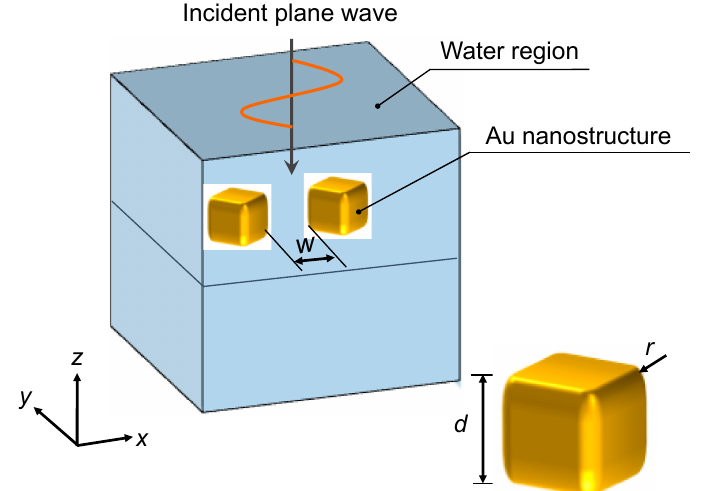
Figure 3. Numerical model of LSPR and photothermal calculation for gold nanostructures immsed in water with indicent plane wave from the top.